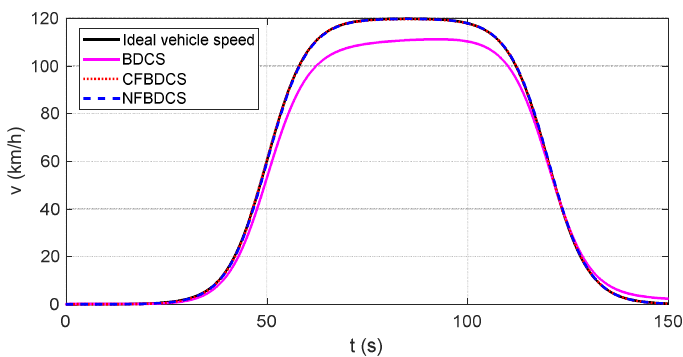
Figure 24. Vehicle speed tracking performance under uncertain conditions.